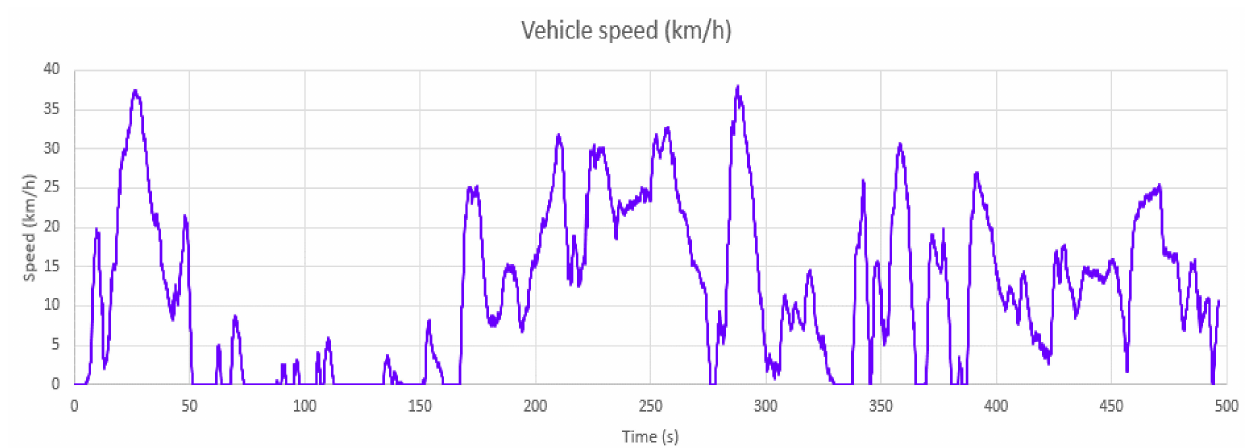
Figure 9. Velocity estimated from acceleration using IMU.